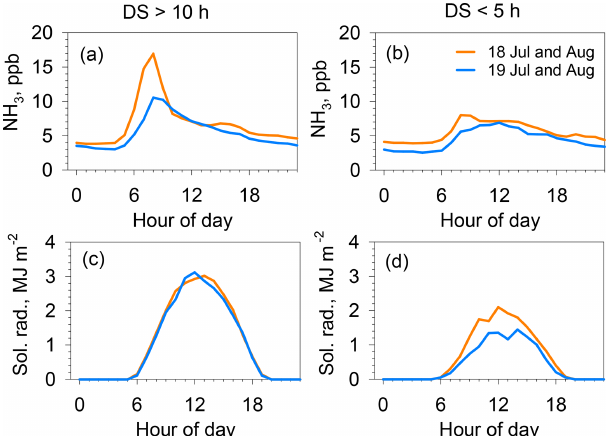
Figure 5. Hourly average of NH 3 concentration (a, b) and solar ra- diation (c, d) during July–August in 2018 (orange) and 2019 (blue). (a, c) Averages for fine days, both for daily sunshine > 10h and daily wind speed < 3ms − 1 (11d in 2018; 10d in 2019). (b, d) Averages for cloudy days, for all daily sunshine < 5h, daily wind speed < 3ms − 1 , and daily rain < 3mm (4d in 2018; 7d in 2019). tors. Second, the dry deposition velocity of NH 3 varies with